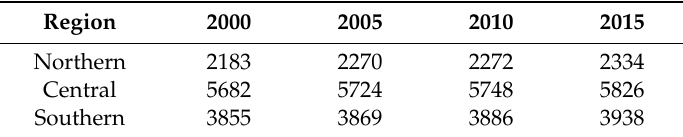
Table 1. The number of rural residential